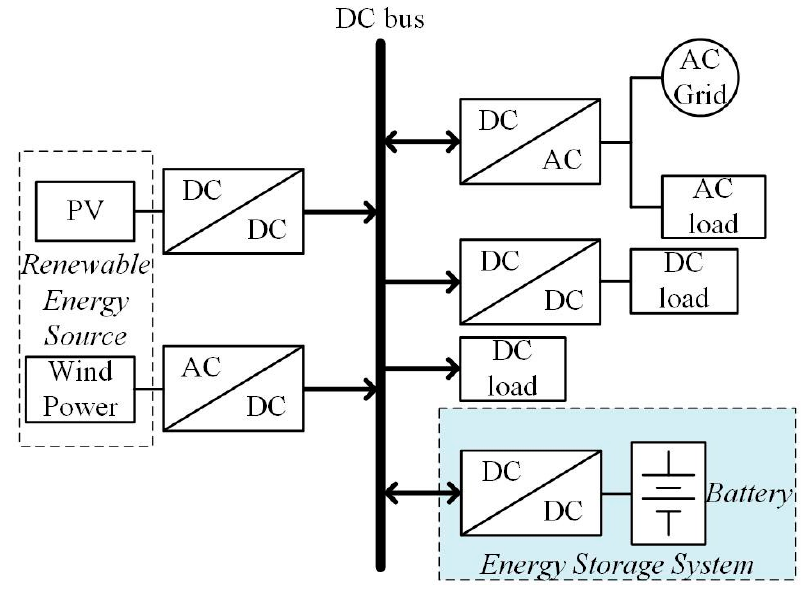
Figure 1. Energy storage system in DC microgrid.